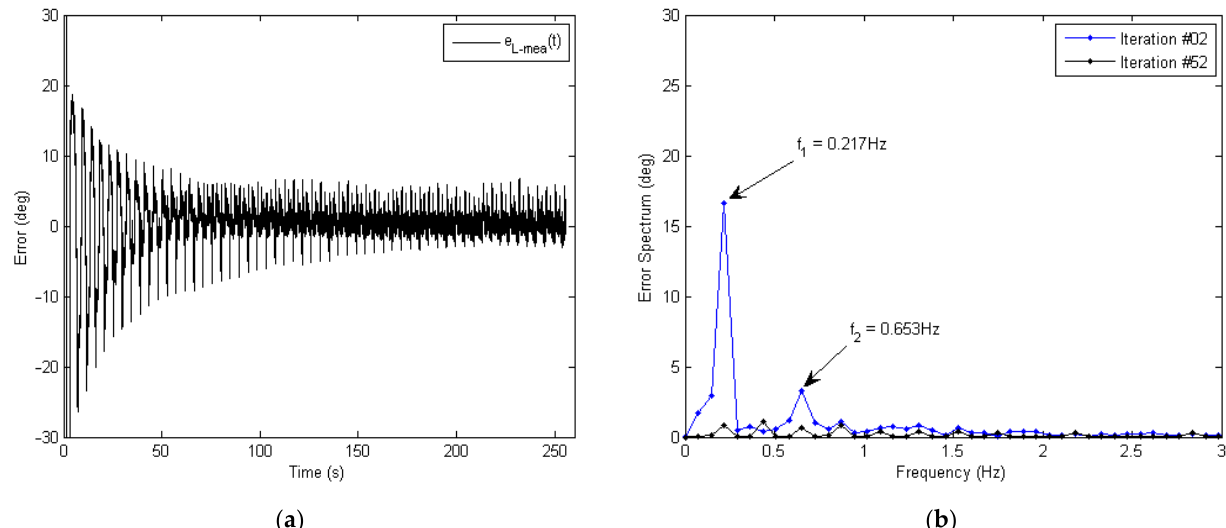
Figure 19. Convergence of the measured tracking error for the outer learning loop, where the learning gain is 𝜑 = 0.2 , and the phase-lead compensation level is 𝛾 = 10 . ( a ) Time-domain con- vergence of the measured knee joint tracking error 𝑒 𝐿−𝑚𝑒𝑎 (𝑡) . ( b ) Frequency-domain comparison of the tracking error spectrum 𝐸 𝐿−𝑚𝑒𝑎 (𝑓) at iterations #02 and #52. After learning, the dominant error components at frequencies 𝑓 1 = 0.217 Hz and 𝑓 2 = 0.653 Hz wereattenuated by 95.1% and 80.2%,